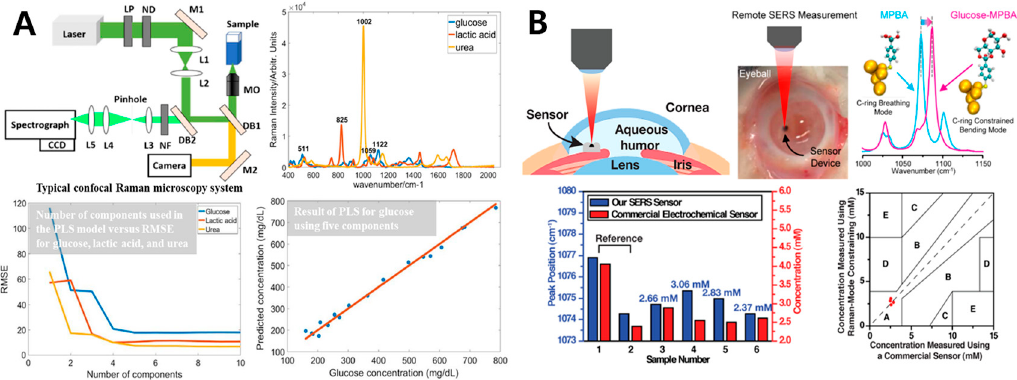
Figure 5. Raman spectroscopy methods. ( A ) multicomponent analysis using a confocal Raman microscope. Adapted with permission [68]. Copyright 2018, Optical Society of America. ( B ) Glucose sensing using surface-enhanced Raman-mode constraining. Adapted with permission [69]. Copyright 2018, American Chemical Society.